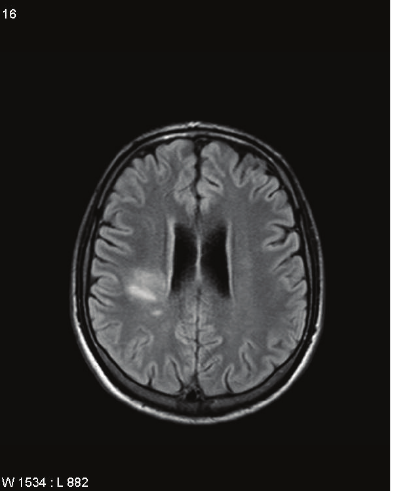
Figure 1: An emergency brain angio-computed tomography (A-CT) evidenced thrombosis of the M2 tract of the right middle cerebral artery.